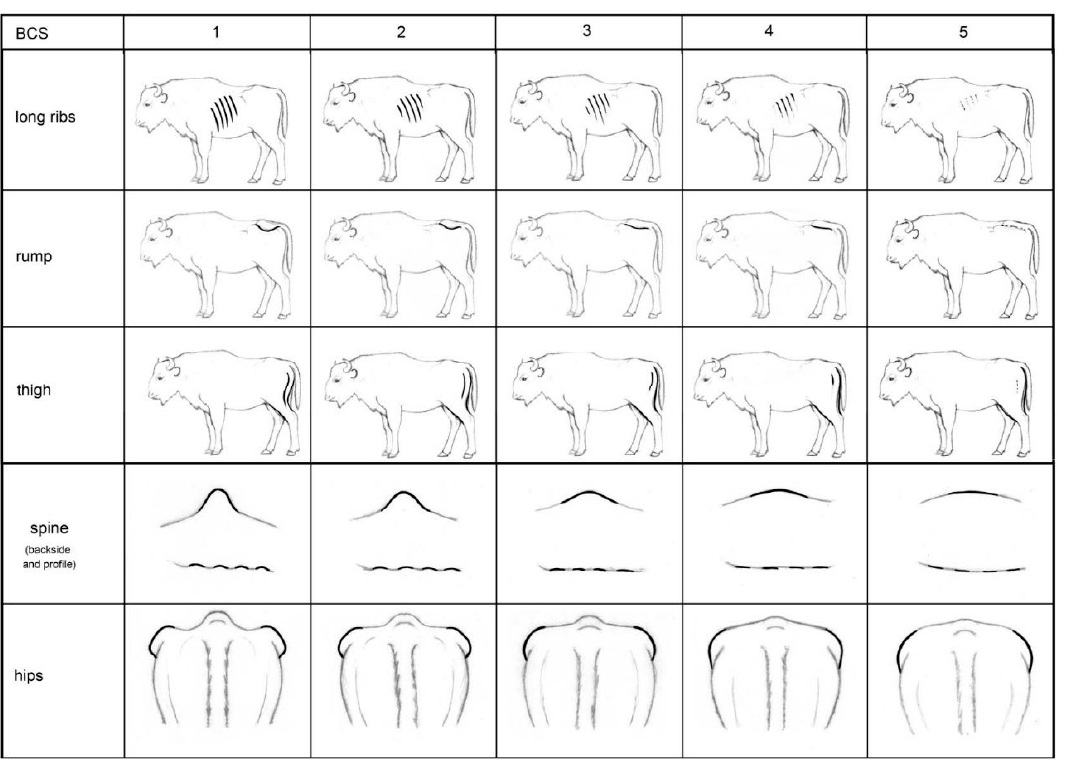
Figure S1: Body condition scheme (BCS) for European bison ( Bison bonasus ) with a five-point scale ranging from score 1 (emaciated) to score 5 (obese), Figure S2: Pictures of ten adult European bison ( Bison bonasus ) photographed from the left side and from behind, Figure S3: Box plots of the given scores per animal per assessors’ category; Figure S4: Kendall’s tau correlation matrix of all single trait scores including the derived overall